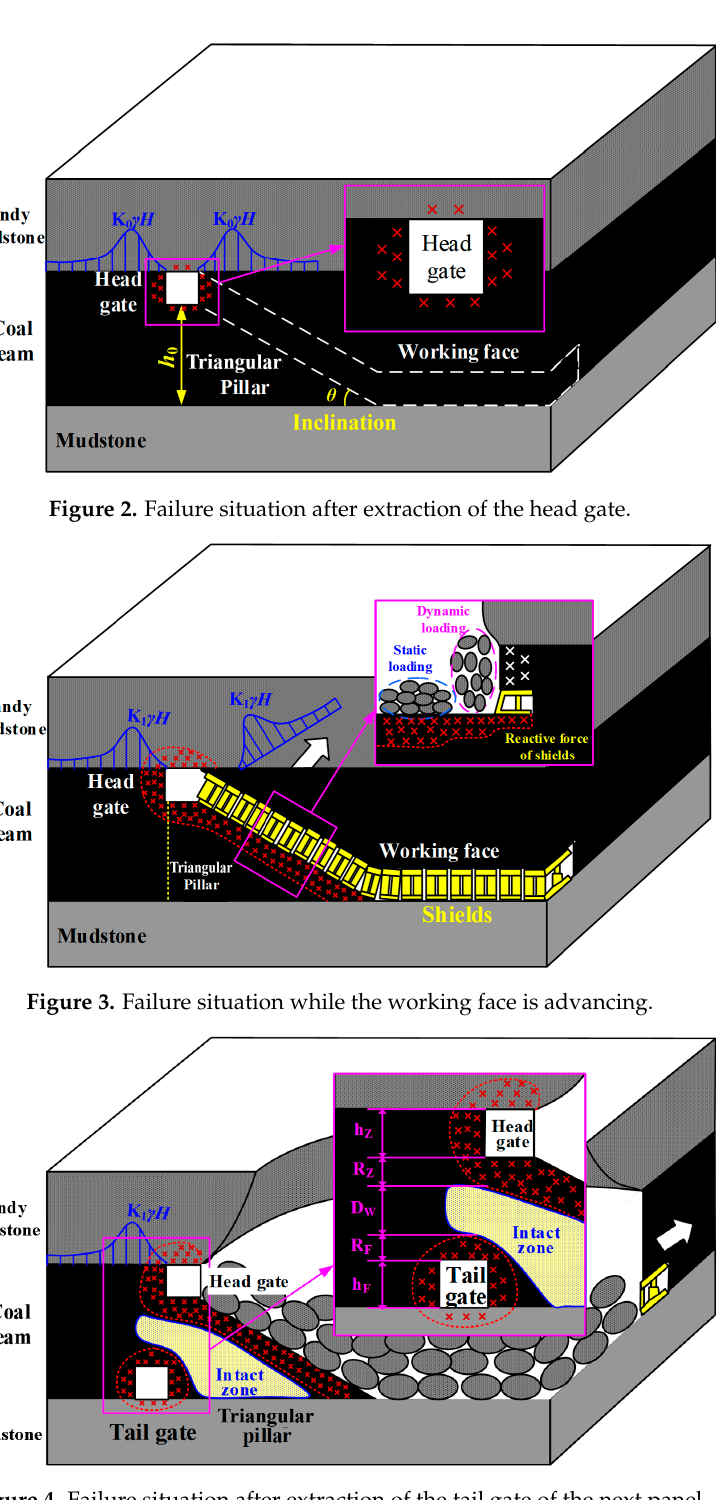
Figure 4. Failure situation after extraction of the tail gate of the next panel.